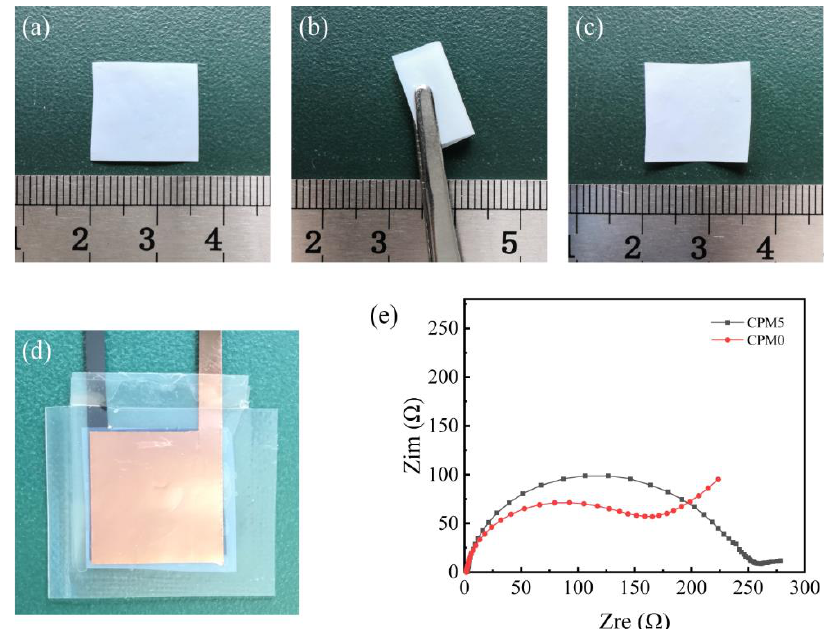
Figure 7. ( a – c ) Photographs of CPM-5 before folding, after folding, and released, respectively. ( d ) Photograph of a LiFePO 4 /CPM-5 gel electrolyte/graphite battery cell. ( e ) The EIS of the assembled LiFePO 4 /CPM gel electrolyte/graphite cell.